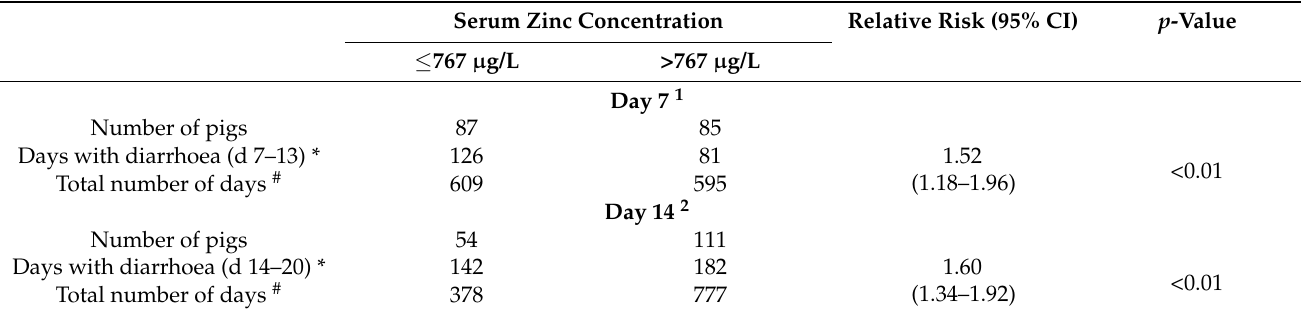
Table 4. Relative risk of diarrheal episode over the second and third week post weaning by dividing the pigs into two groups depending on if their serum zinc level was higher or lower than weaning level (767 µ